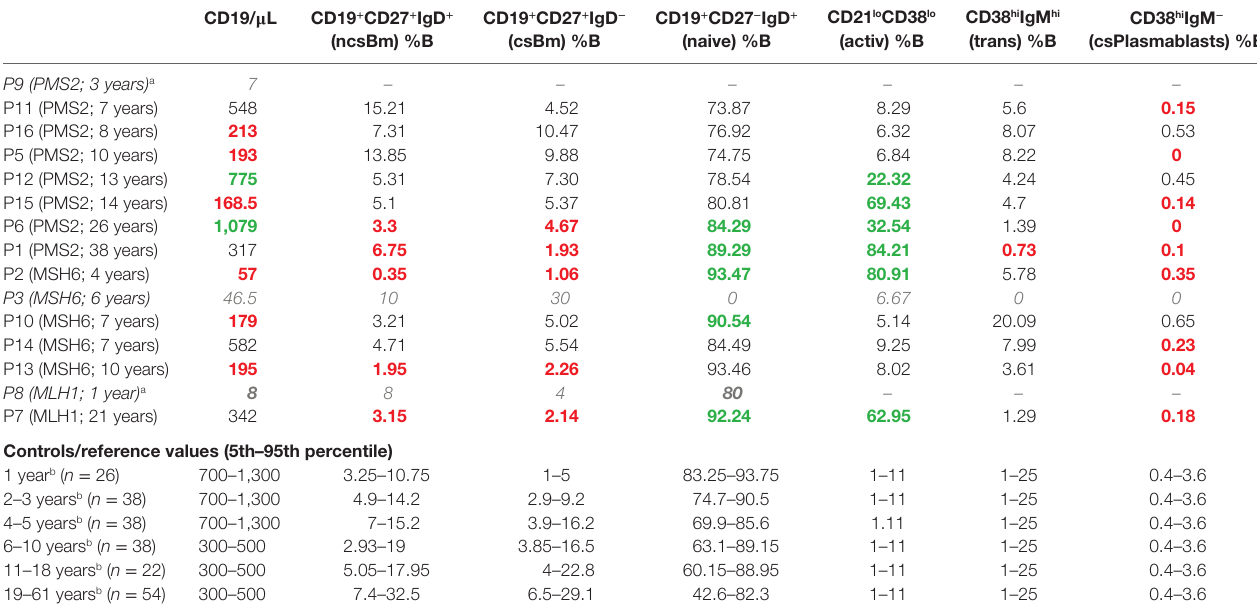
TaBle 3 | Quantification of B cell subsets of CMMRD